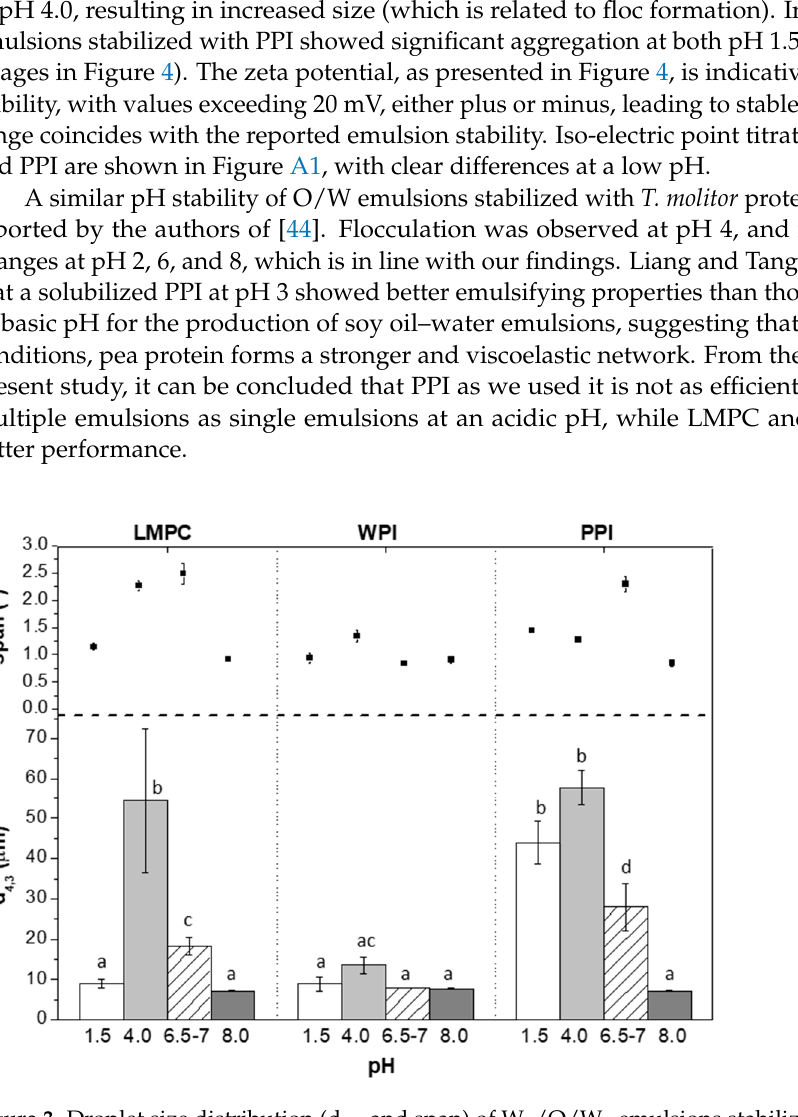
Figure 3. Droplet size distribution (d 4,3 and span) of W 1 /O/W 2 emulsions stabilized with LMPC, WPI and PPI after 14 days of incubation at pH 1.5, 4.0, 6.5–7, and 8.0. Different letters on top of the bar mean significant differences at p <